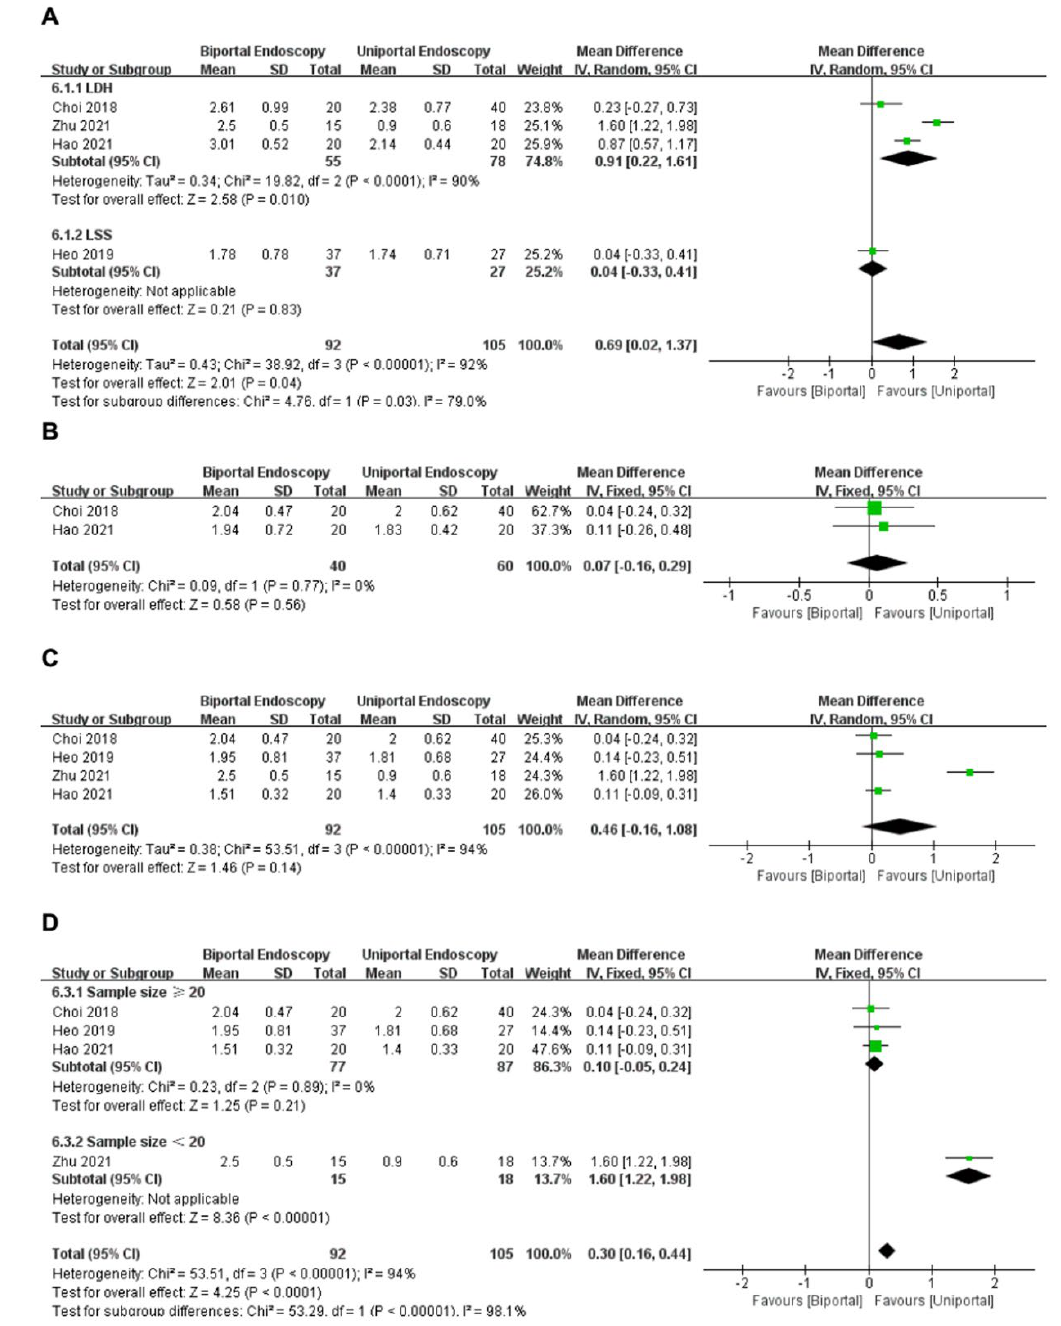
Figure 3. Forest plot of VAS back pain score ( A ) subgroup analysis within 3 days; ( B ) within 3 months; ( C ) last follow-up; ( D ) subgroup analysis at the last follow-up Choi et al., 2018 [15]; Heo et al., 2019 [16]; Zhu et al., 2021 [14]; Hao et al., 2021